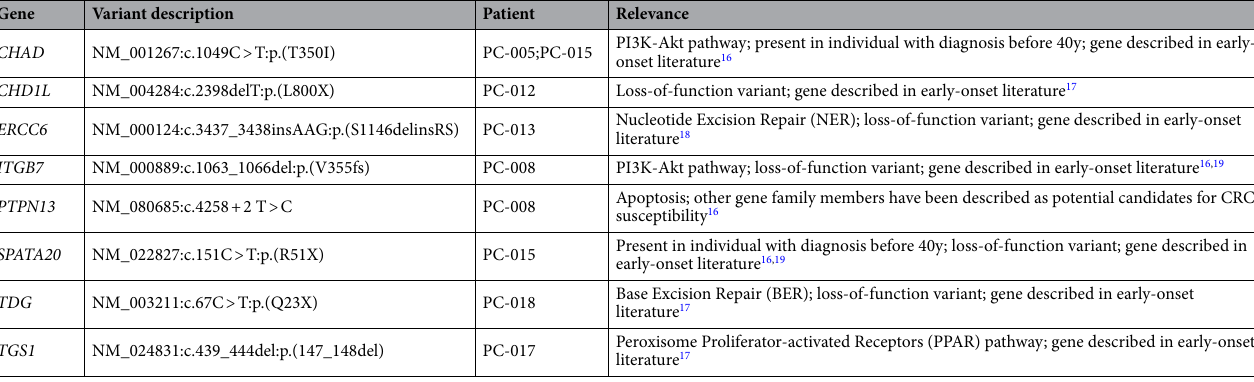
Table 1. Candidate variants in the discovery cohort. Potential risk genes identified in the discovery cohort and selected for replication, with their corresponding detected rare, high-impact